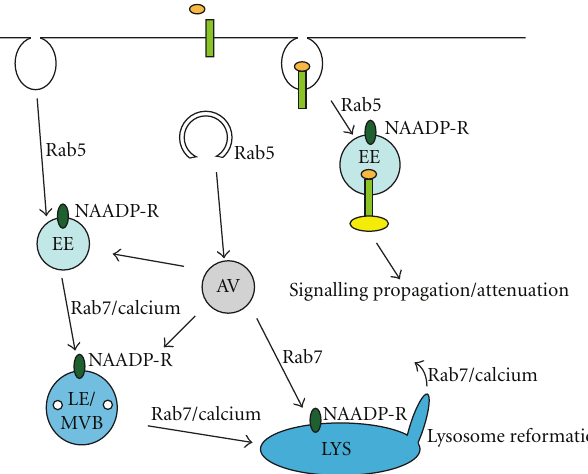
Figure 2: Possible mechanisms by which LRRK2 may regulate events related to endolysosomal and autophagic function. Modulation of rab5 function could cause changes in endocytosis and/or autophagosome formation. Altered endocytosis could also modulate signalling events occurring at the plasma membrane or on intracellular organelles, thereby, indirectly impacting upon autophagy through phosphorylation events of distinct proteins required for the process. At later stages, through modulating rab7 function, LRRK2 may alter the fusion of autophagosomes/endosomes with lysosomes or impair lysosome reformation, which would impact upon autophagic-lysosomal clearance in both cases. As most of the abovementioned membrane fusion/reformation steps require intraluminal calcium, LRRK2 may further regulate endolysosomal clearance by modulating NAADP-sensitive calcium channels (NAADP-R) located on endosomes and lysosomes. The increasing intraluminal calcium concentrations along the endocytic/lysosomal pathway are indicated by the progressively darkened blue color. Ligand binding to receptors, followed by endocytosis and interaction with signalling complexes are schematically indicated. EE: early